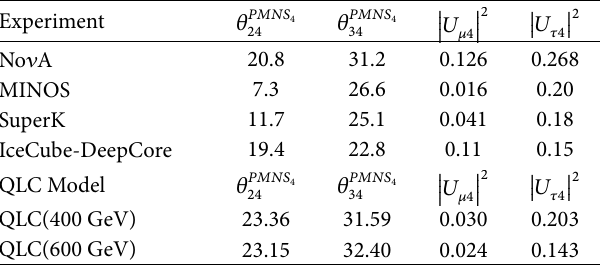
Table 4: The upper limits of sterile mixing parameters obtained from model(QLC) and from NO 𝜈 A, MINOS, Super-Kamiokande and